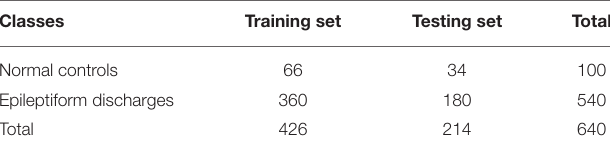
TABLE 2 | Class distribution of the samples in the training and test data sets.